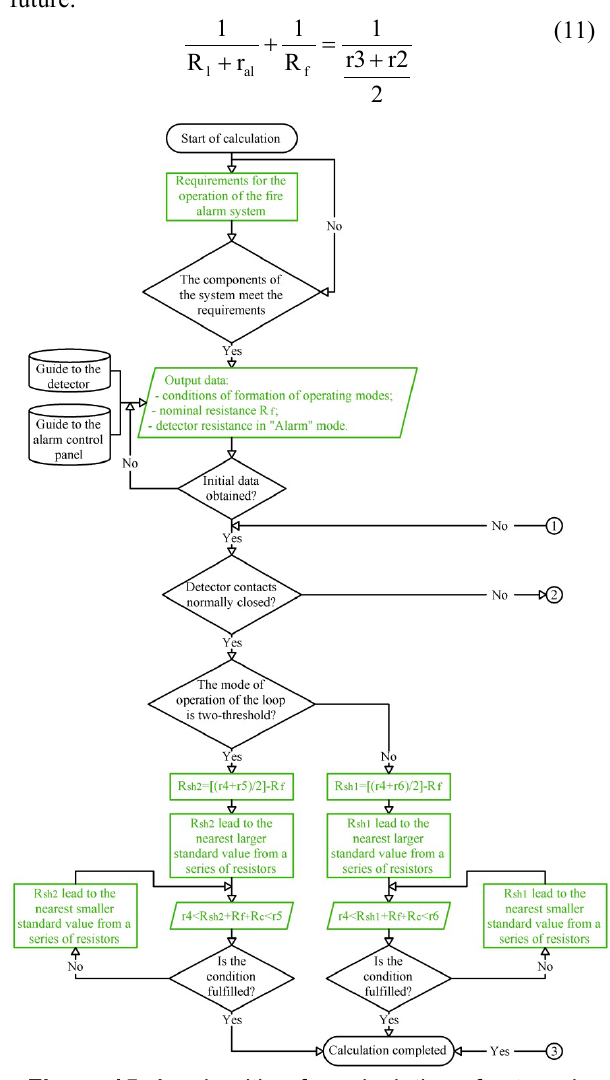
Figure 15. An algorithm for calculation of external components of FAL (beginning)